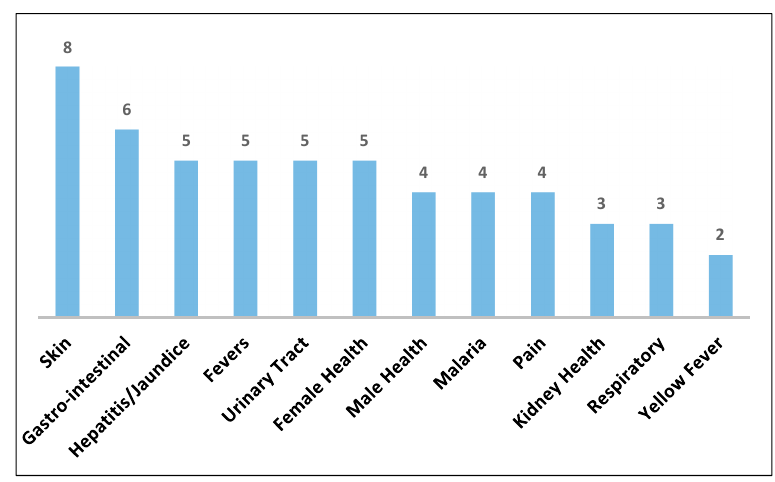
Figure 5. Number of species of Cochlospermaceae (indicated above bar) used for selected medicinal uses.